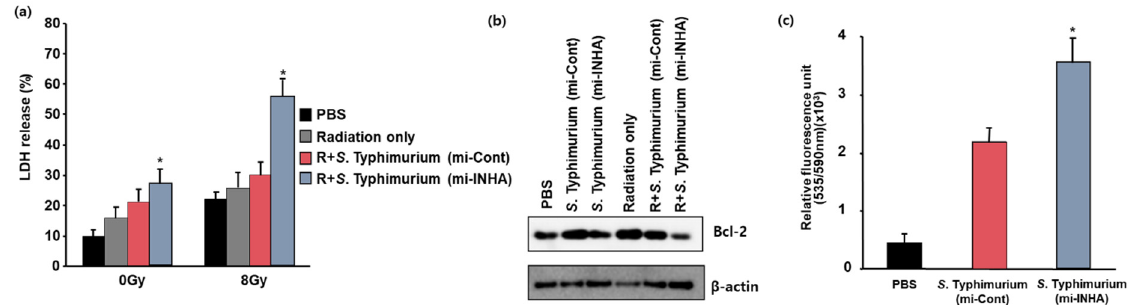
Figure 3. Combinatory effects of S. Typhimurium expressing mi-INHA and radiation in B16F10 cells. ( a ) LDH cytotoxicity assays were performed on cell-free supernatants from B16F10 cells. Cytotoxicity was determined by measuring the amount of LDH released from PBS-treated cells or S. Typhimurium -treated cells into the supernatant with respect to cells exposed to a detergent. Each data point represents the mean ± SEM of three independent experiments (* p < 0.05 vs. PBS-treated controls; Student’s t -test). ( b ) Western blotting was used to detect the expression patterns of Bcl-2, b-actin, and INHA. The blots are representative of three independent experiments. Western blot normalized to β -actin was added as supplementary material (Supplementary Figure S2). ( c ) ROS production was measured by FACS analysis in B16F10 cells using 10 μ M of H2DCFDA, which converts to a fluorescent derivative only in the presence of ROS. Flow cytometry histogram data were added as supplementary material (Supplementary Figure S3). Results shown are representative of at least three independent experiments.